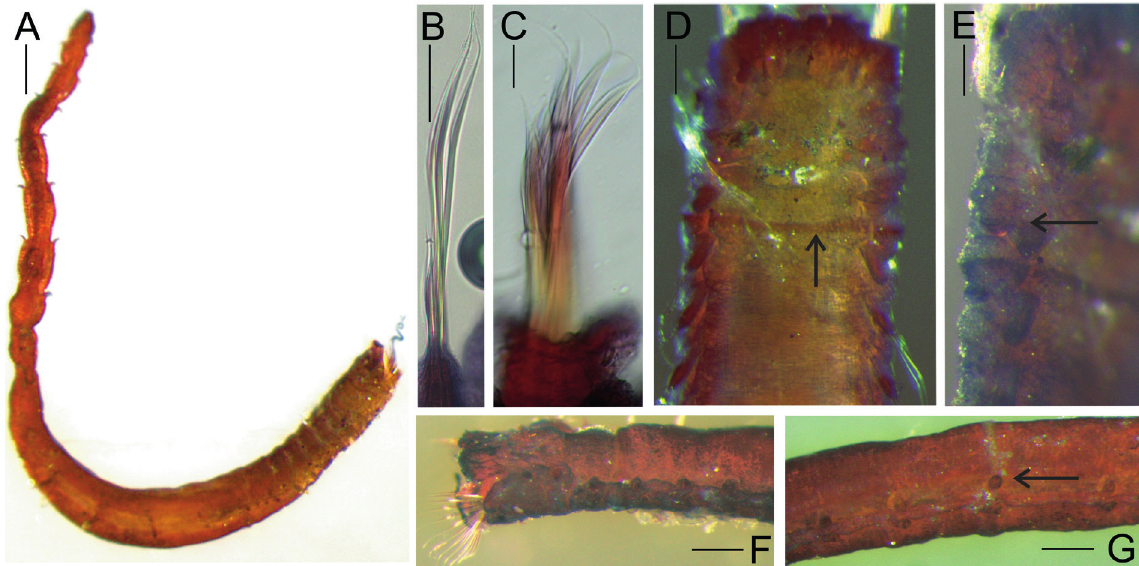
Fig. 3. Anobothrus konstantini Säring & Bick sp. nov. Micrographs of ShirlastainA staining